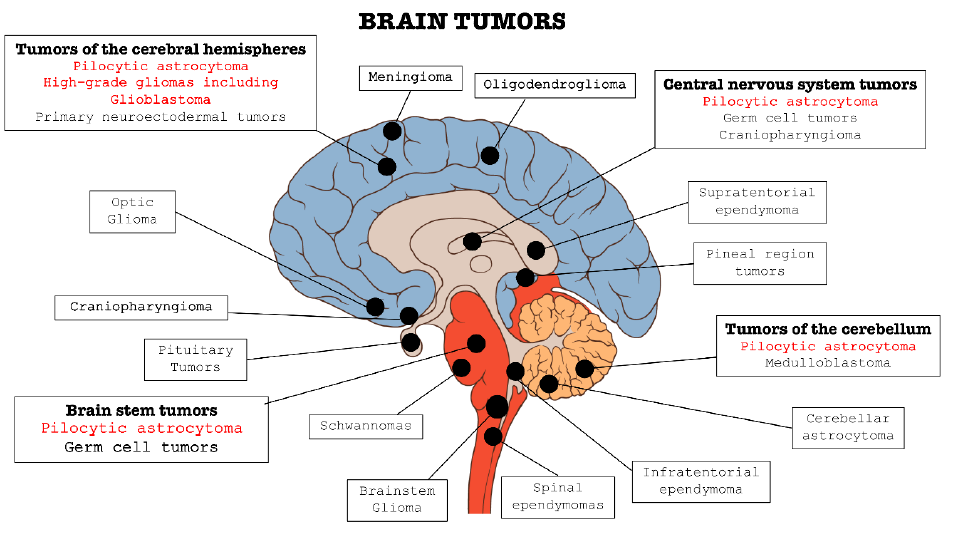
Figure 1. Classification of the main brain tumors; the tumors involved in this review are highlighted in red.